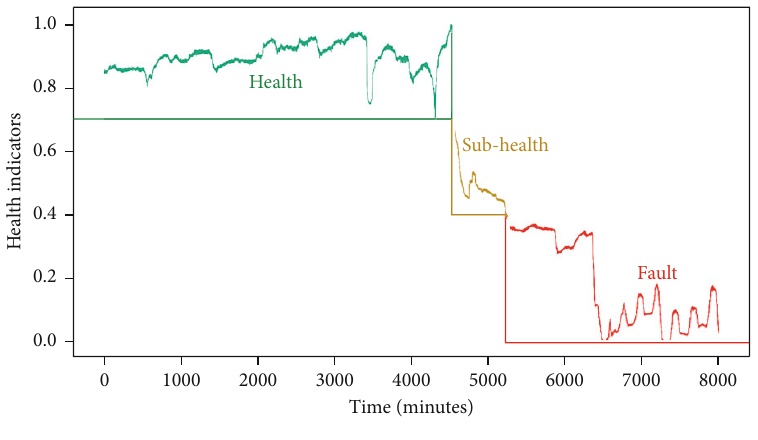
Figure 1: Change curve of the health status.